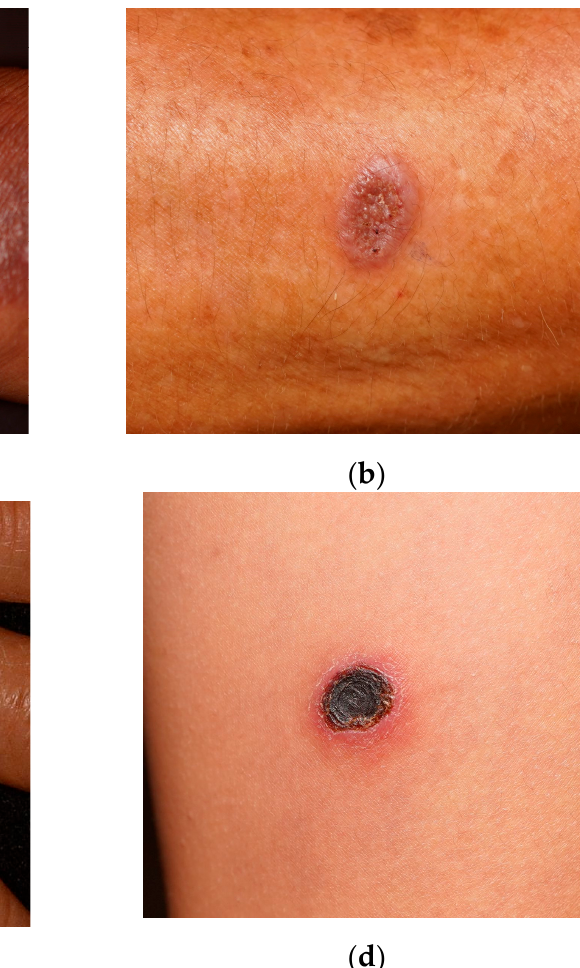
Figure 1. Common appearances of implantation mycoses: ( a ) papuloplaques on the dorsal hand ( Mucor sp.); ( b ) papuloplaque with a verrucous surface ( Nigrospora ); ( c ) nodule on the dorsal hand (unknown pathogen); and ( d ) ulceration on posterior thigh (unknown pathogen).